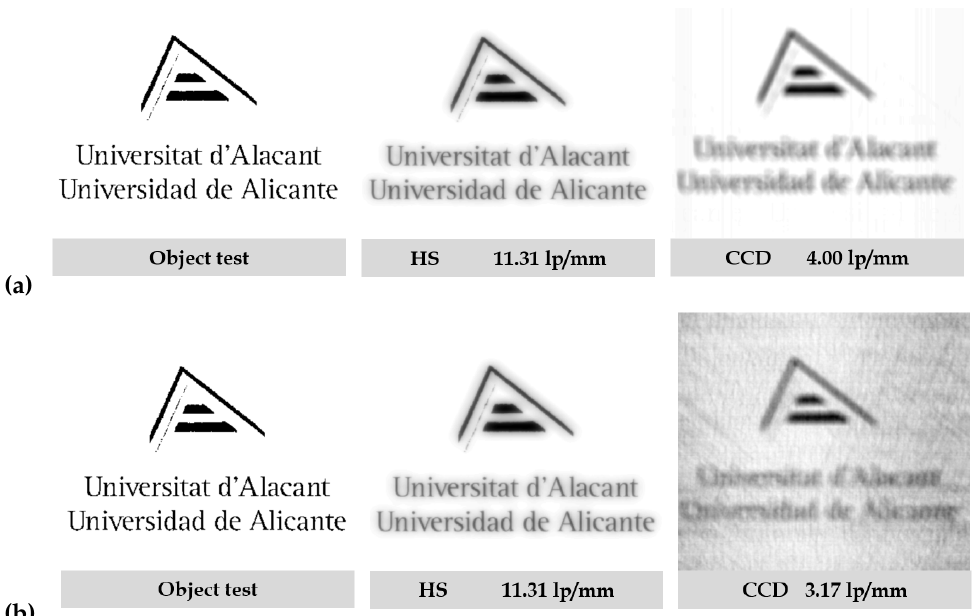
Figure 8. Convolution simulations of an object test (University of Alicante logo) with the ASFs obtained by the different methods (HS wavefront sensor and CCD sensor) using as reconstruction wavelength: ( a ) 473 nm and ( b ) 633 nm.